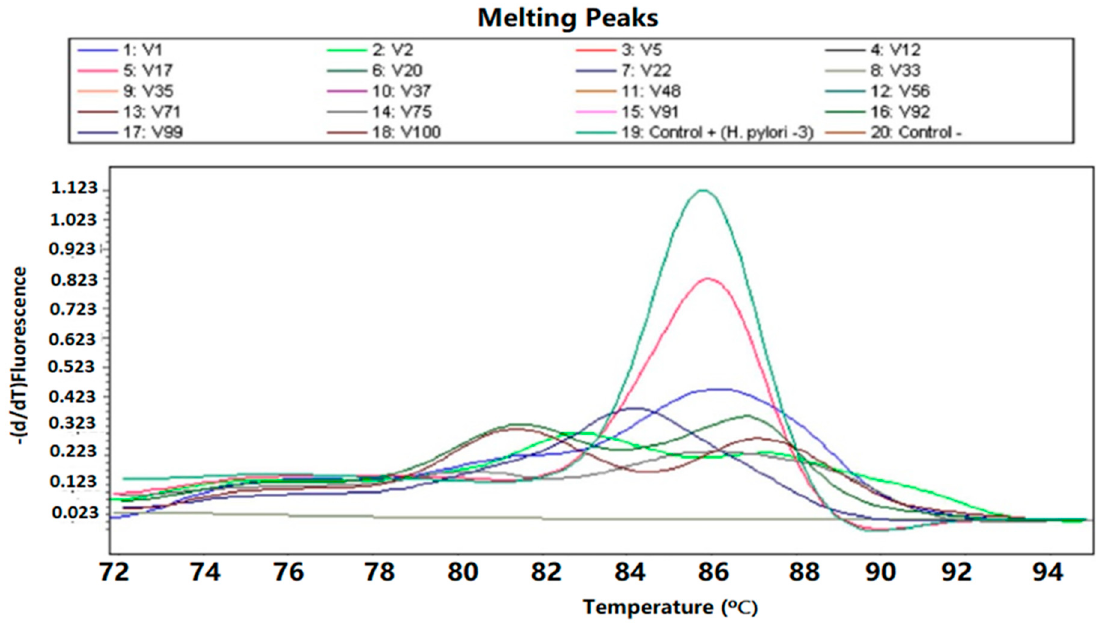
Figure 1. Melting curves obtained for H. pylori vacA gen quantitative detection from raw vegetables, including: curve 19, positive control (T m 86 ◦ C); curve 15, V91 peak detected in spinach (T m 85.4 ◦